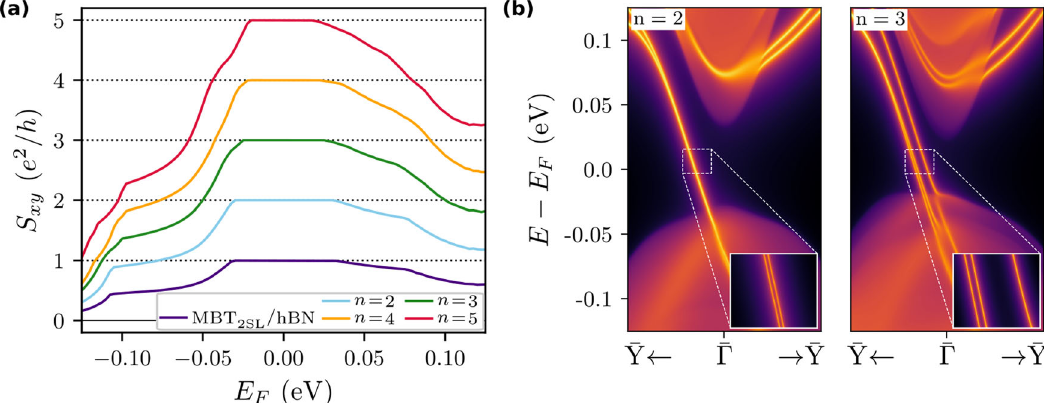
Fig. 4 Anomalous Hall conductance and edge spectra for the n MBT 2SL /hBN multilayers. a The Fermi energy dependence of anomalous Hall conductance S xy ( E F ) in the units of conductance quantum e 2 / h for MBT 2SL /hBN and n MBT 2SL /hBN, n = 2, … , 5. E F = 0 corresponds to the center of the band gap in each case. b The edge electronic structure of n MBT 2SL /hBN for n = 2 and n =